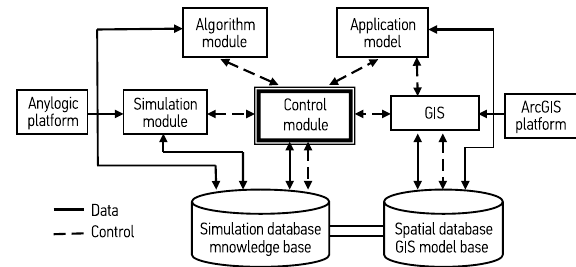
Emergencyhandling processsimulation